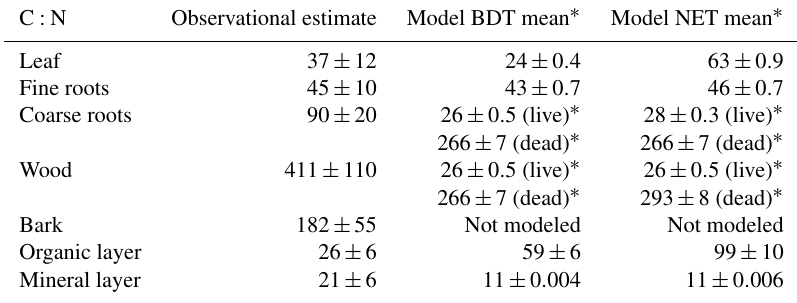
Table 2. Mean C : N values for plant and soil pools reported in site-specific literature and simulated by CLM5 (averaged across sites). Model means ( ± 1 standard deviation across simulated sites) are the average of C : N ratios from the last 20 years of the baseline simulation from simulations with a closed N cycle. Observational means ( ± 1 standard deviation across measured site data) are based off site-reported or field-estimated values for C : N ratios, which are listed for each site, along with their references (which describe the sampling methods for each pool) in Table S3. C : N Observational estimate Model BDT mean